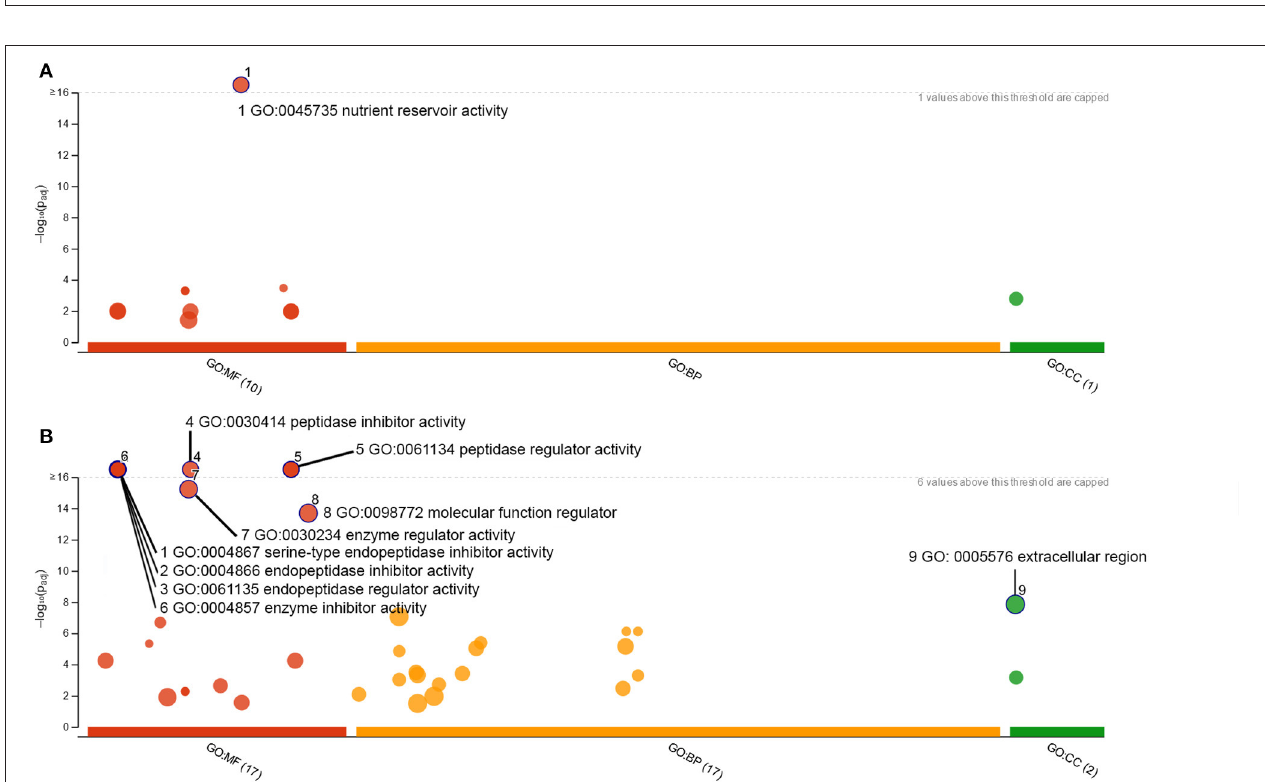
FIGURE 3 | Relative abundance of different gluten or ATI protein groups (A) . Quantitation was performed based on all detectable peptides from proteins classified to these groups. Error bars indicate SEM, and significant differences are indicated by asterisk. Adding together the LMW and HMW glutenins, and α -, γ -, ω -gliadins gives the net gliadin and glutenin content (B) which equated to GW having an estimated 67% of the gluten content of MW (dotted line).